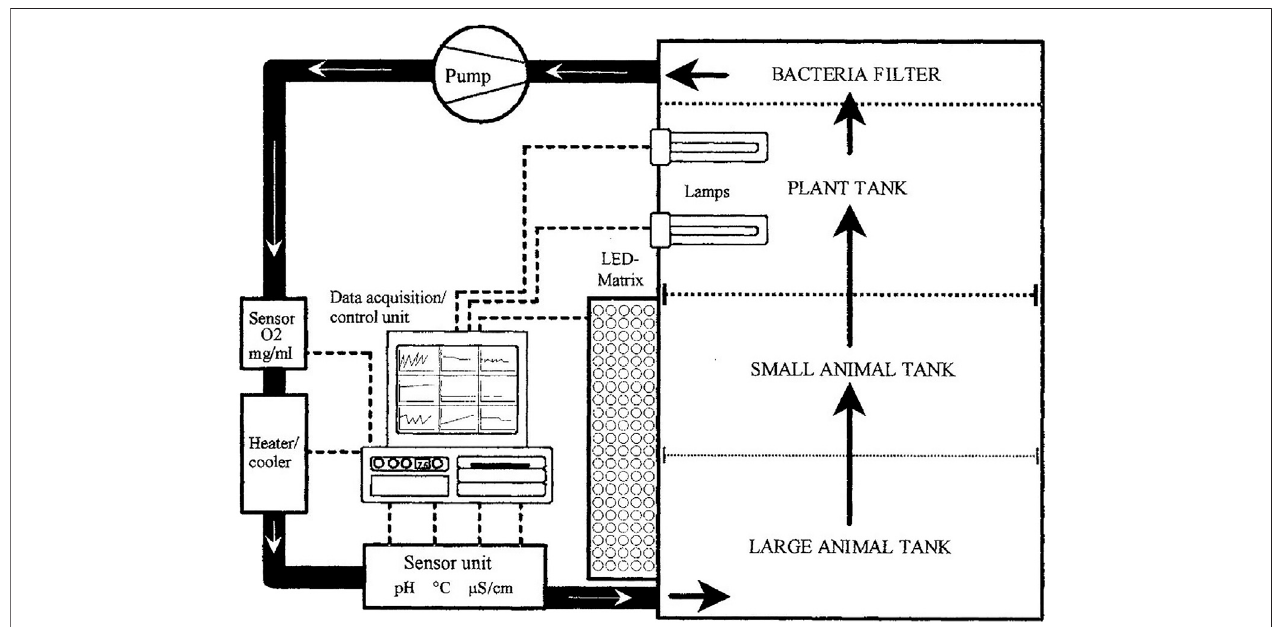
FIGURE 3 | Aquatic CEBAS module diagram demonstrating the trophic chain concept (extract from Bluem et al., 2000).